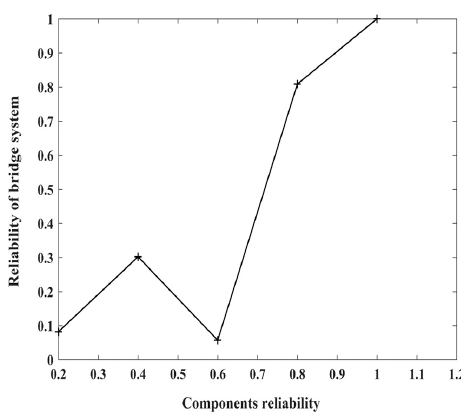
Figure 5. Reliability of a bridge system versus component reliability.